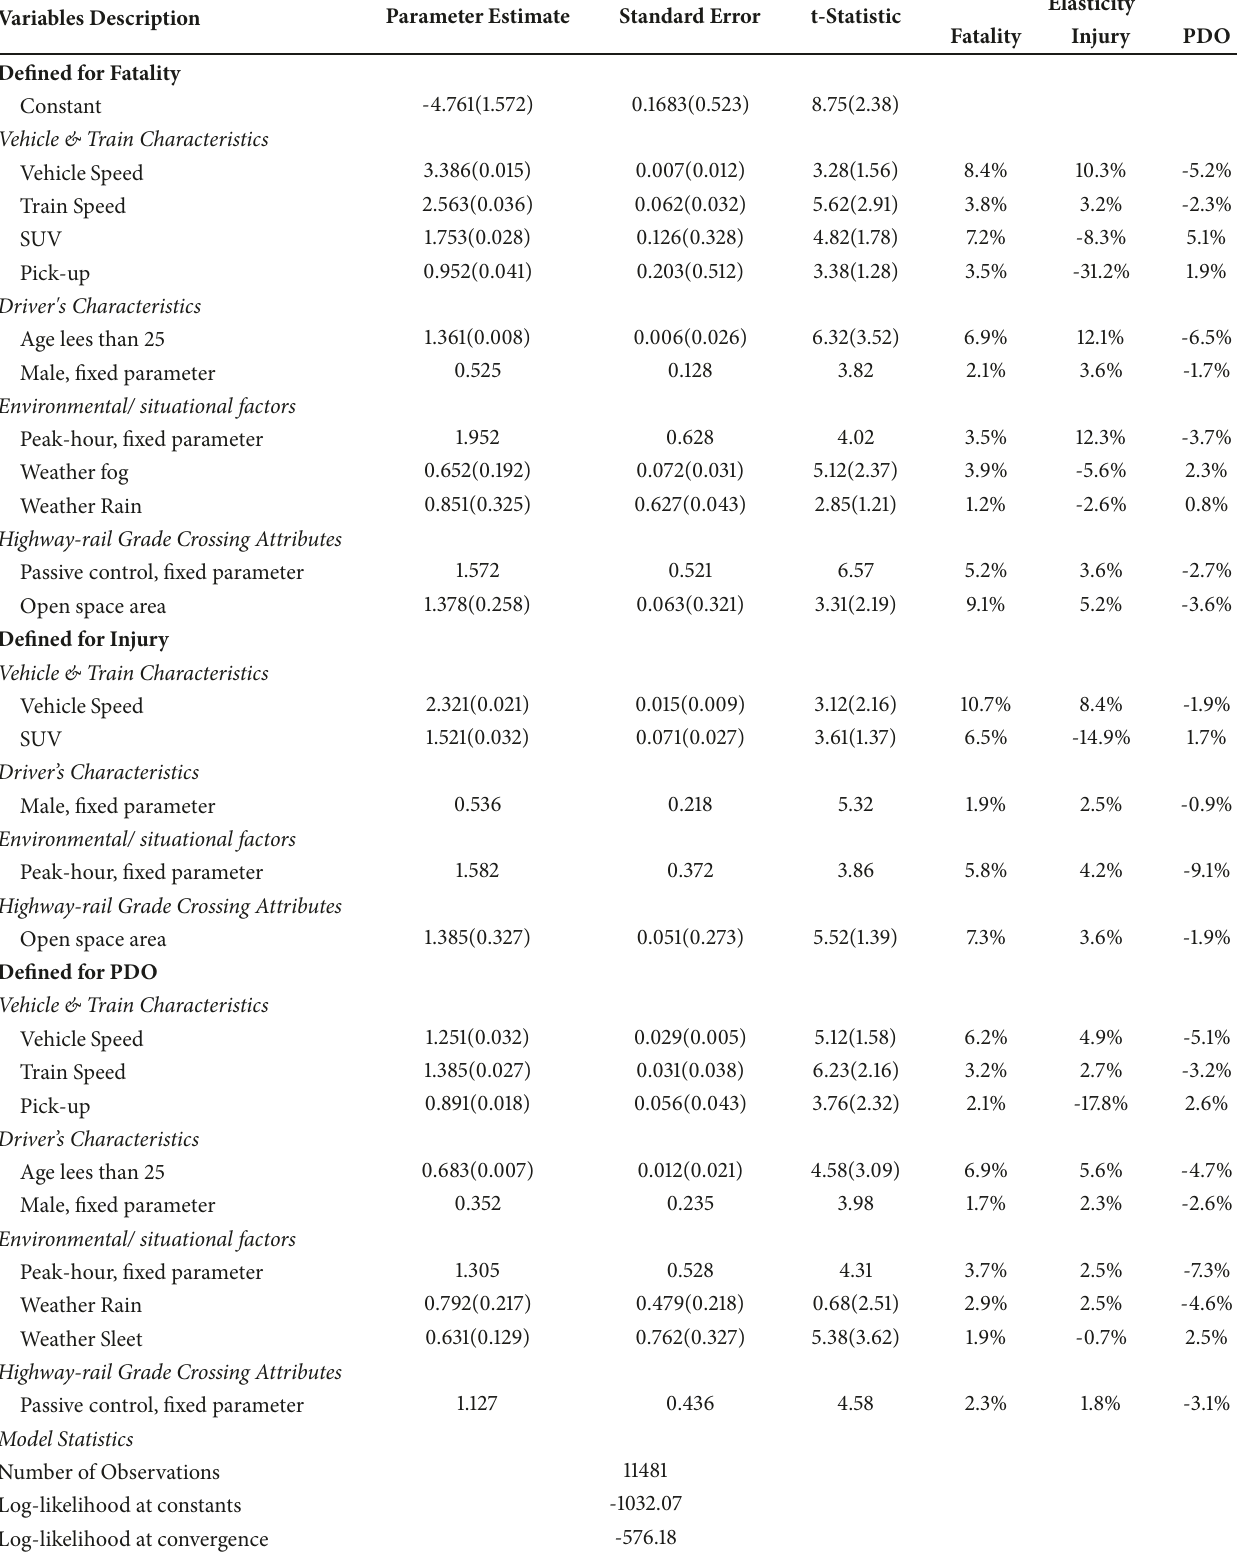
Table 3: Mixed Logit Model Estimation Results for Drivers with Appropriate Driving